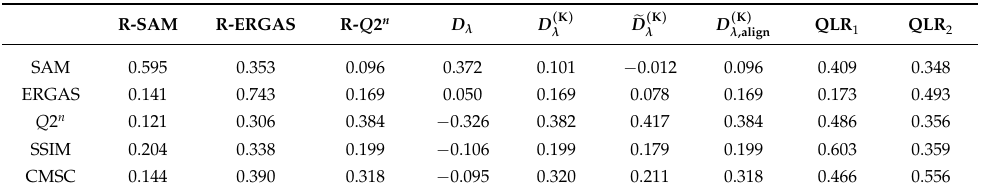
Table 3. Correlation coefficient among different indexes (some have been complemented for a uniform polarization) obtained on the aligned RR WV2 datasets.